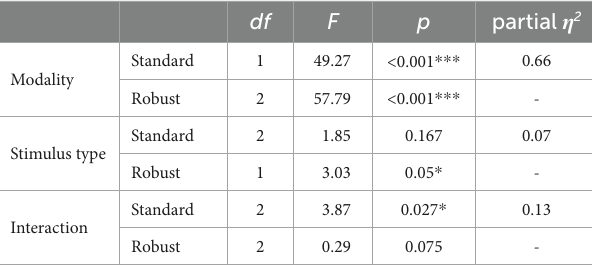
TABLE 2 Results of 2 × 3 repeated-measurements ANOVA (rmANOVA) with the within-subject factors “modality” (VR vs. PC) and “stimulus type” (face vs. blurred vs.